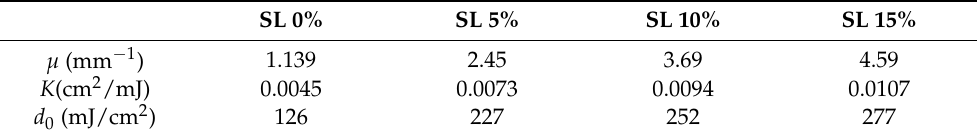
Figure 8. Evolution of reactivity behaviour front solid load incorporation. From the slopes of each line, ( a ) the µ and ( b ) K values are obtained for each formulation according to Equation (1). Table 2. Material FPP parameters and exposure energy dose required to achieve a full conversion ratio during the printing process according to the reinforcement solid load